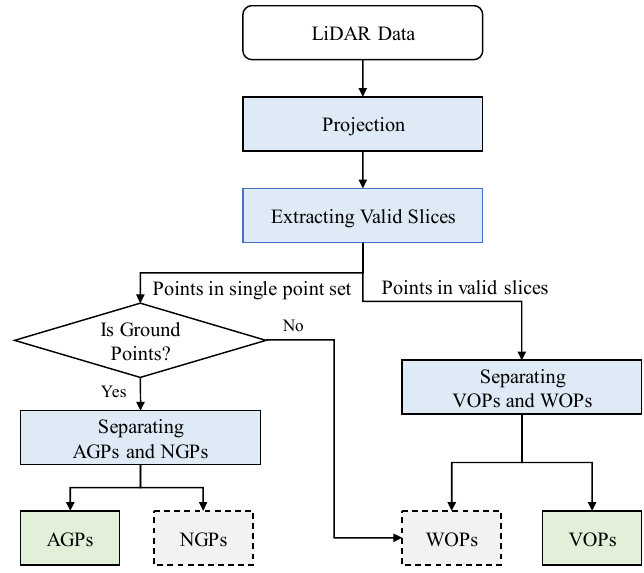
Figure 7. Flowchart of the slice-based projection filtering algorithm.